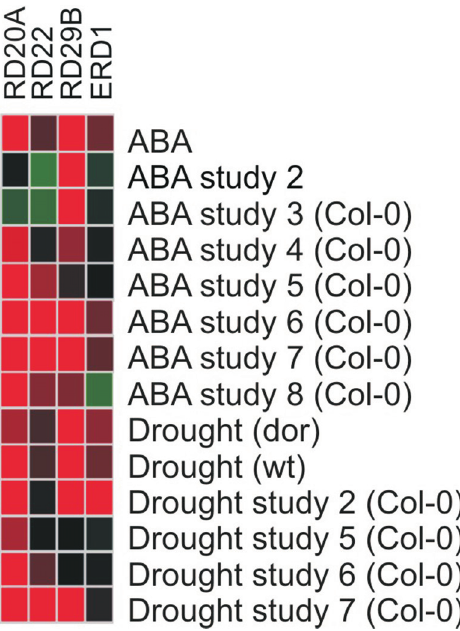
Figure S2 - Digital expression pattern of Arabidopsis DMGs involved in the response to different water privation conditions and ABA stimulus, evalu- atedbytheGenevestigatorwebtool.TheintensityoftheredcolorisequivalenttoincreaseinthegeneinductioninresponsetodroughtstressorABA.The increase in the intensity of the green color is equivalent to increase in the gene repression in response to drought stress or ABA. The black color indicates that it is not induced or repressed under drought stress conditions. Description of experiments: ABA: wild type (Col-0) seedlings, treated with 10 (cid:2) M ABA for 1 h; ABA study 2: Leaf samples from wild type (Col-0) plants, not watered for 7 days; ABA study 3 (Col-0): After stratification at 4 °C for 4 days, wild type seeds were allowed to germinate on the MS-2% sucrose plate containing 0.5 (cid:2) M ABA for two days; ABA study 4 (Col-0): wild type leavesof4week-oldplants,sprayedwith50 (cid:2) MABA.After4h,sampleswerecollected;ABAstudy5(Col-0):PlantsamplesofCol-0grownfor2weeks on MS agar medium with 3% sucrose and then treated with 100 (cid:2) M ABA for 1 h; ABA study 6 (Col-0): Plant samples of wild type (Col-0) grown for 2 weeks on MS agar medium with 3% sucrose and then exposed to dehydration stress for 1 h; ABA study 7 (Col-0): Isolated guard cell samples